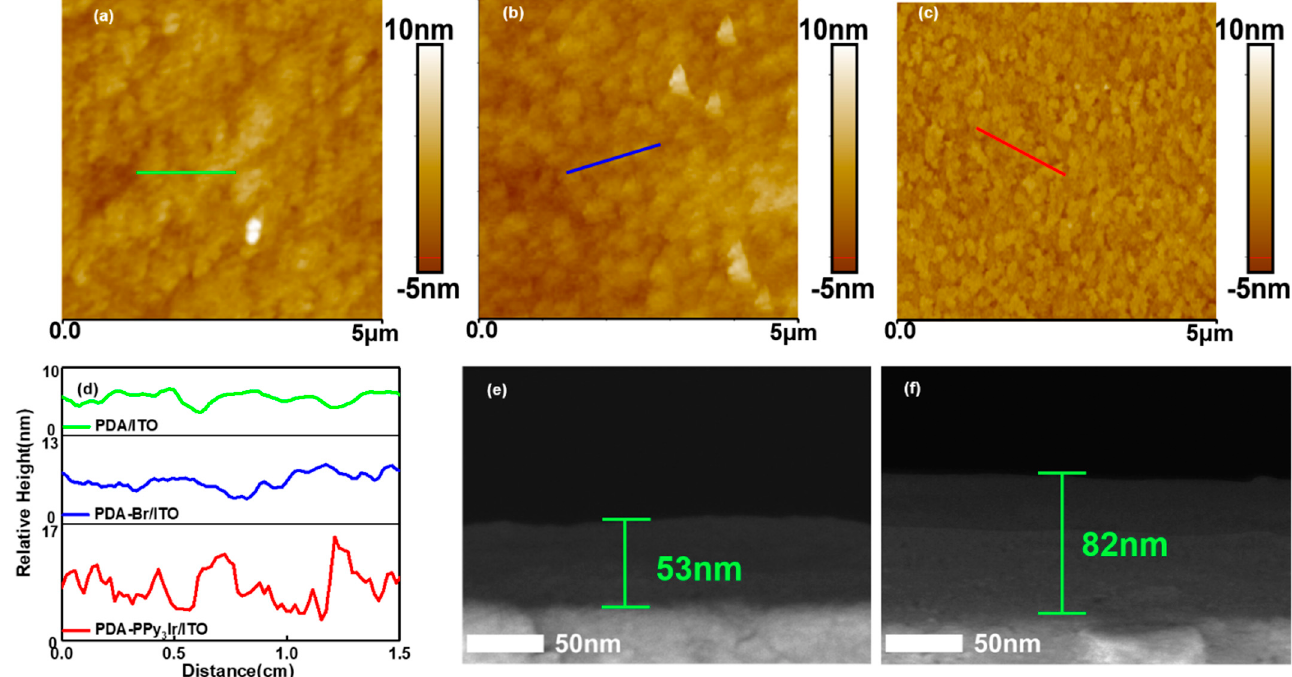
Figure 2. AFM images of ( a ) PDA/ITO; ( b ) PDA-Br/ITO; ( c ) PDA-PPy 3 Ir/ITO substrate; ( d ) height profiles along three lines; FESEM cross-sectional images of ( e ) PDA/ITO and ( f ) PDA-PPy 3 Ir/ITO substrate.